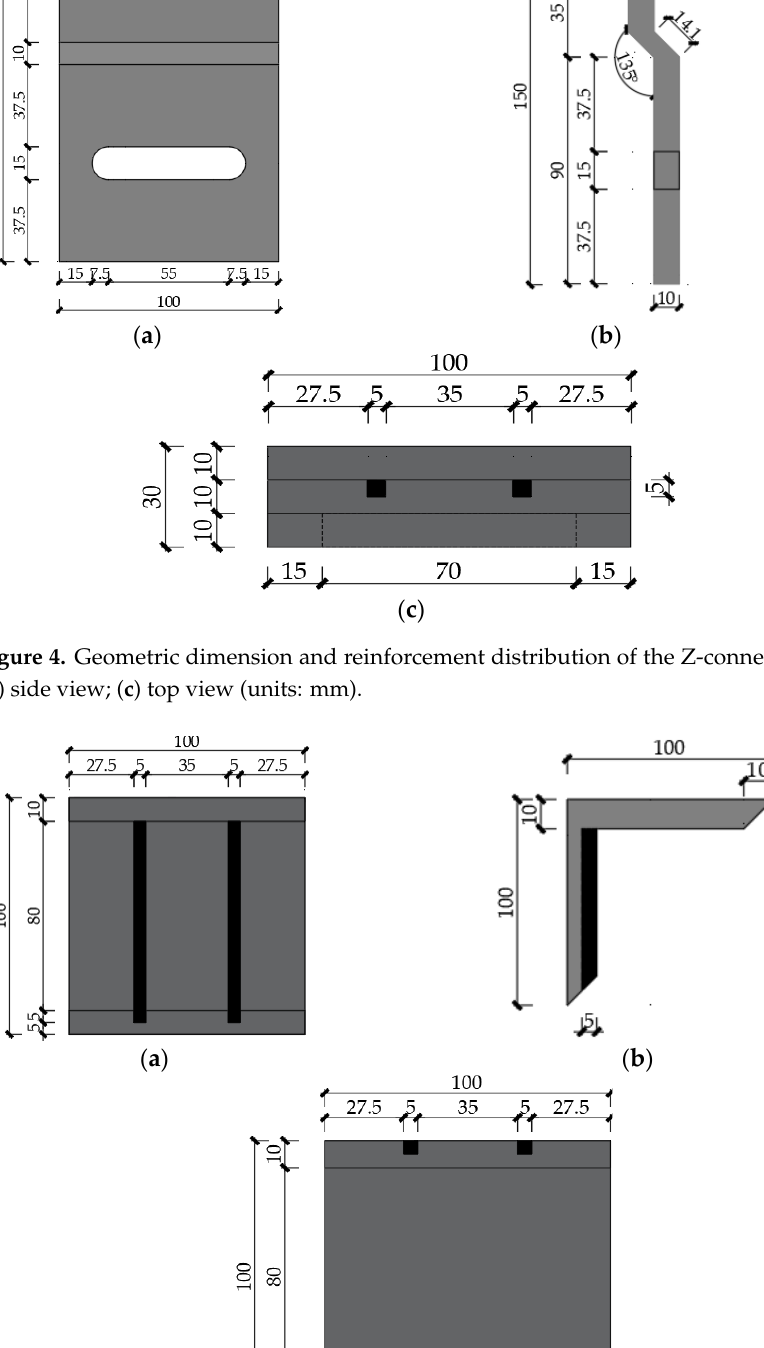
Figure 5. Geometric dimension and reinforcement distribution of the L-connector: ( a ) front view; ( b ) side view; ( c ) top view (units: mm).